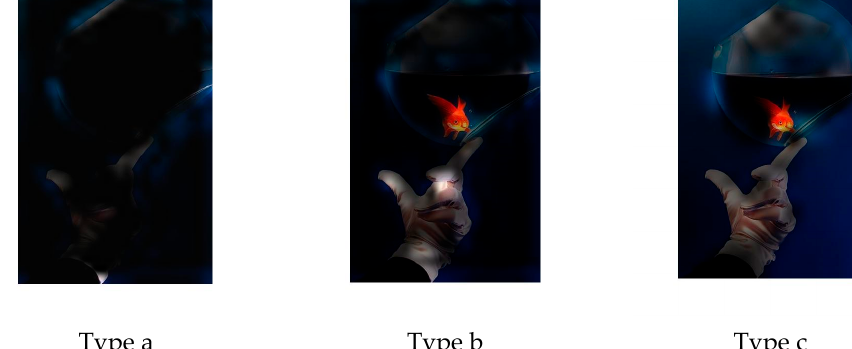
Figure 11. AIR(x, y) of Figure 9.